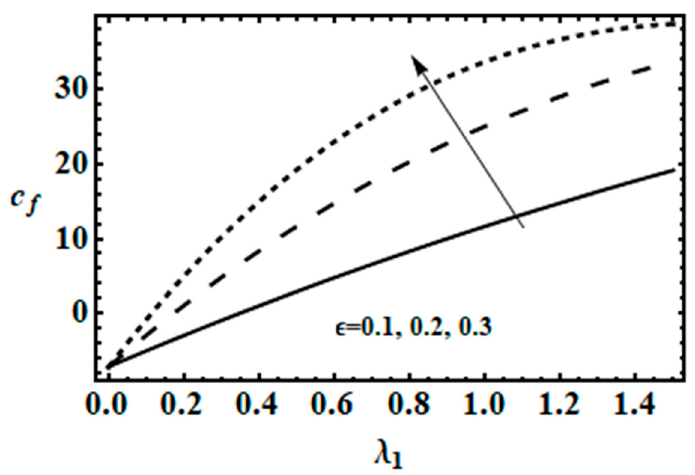
Figure 11. Effect of the cilia length ε on skin friction. Results obtained for α = 0.4, β = 0.4, Re = 0.1, Q = 1.5, M = 1, K = 0.1, λ 1 = 0.1.